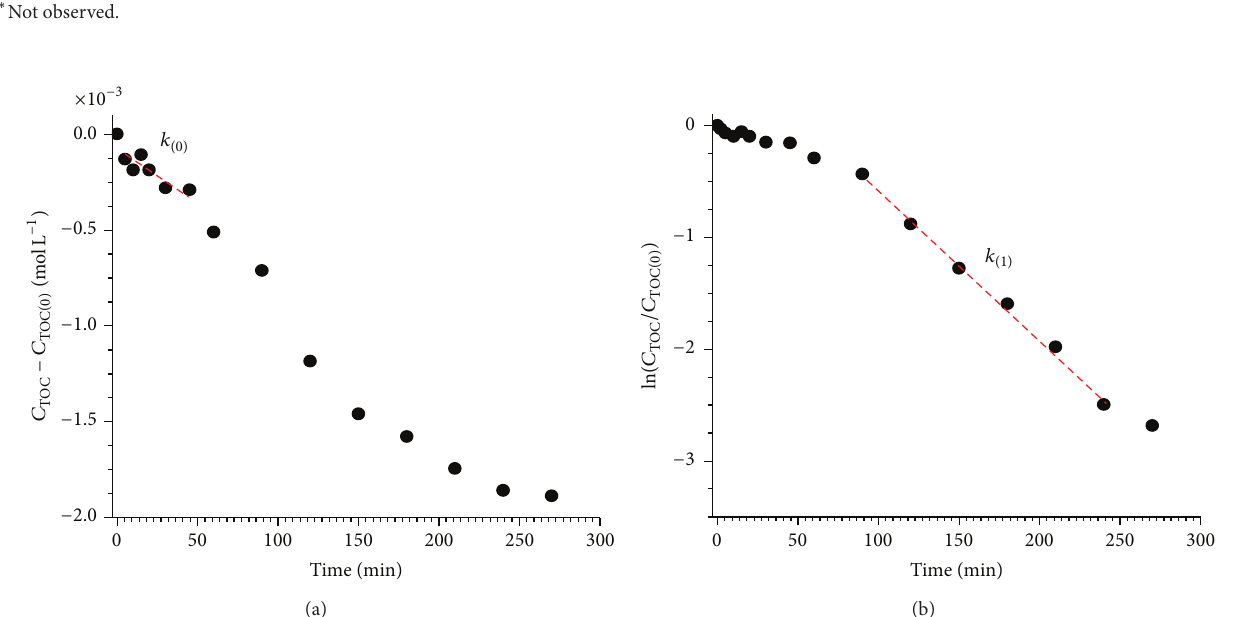
Figure 5: Plots of (a) ( 𝐶 TOC − 𝐶 TOC ( 0 ) ) and (b) ln (𝐶 TOC /𝐶 TOC ( 0 ) ) versus reaction time calculated from the experimental TOC versus time curves of DCF photomineralization in the presence of TS composite, according to (6) and (10).